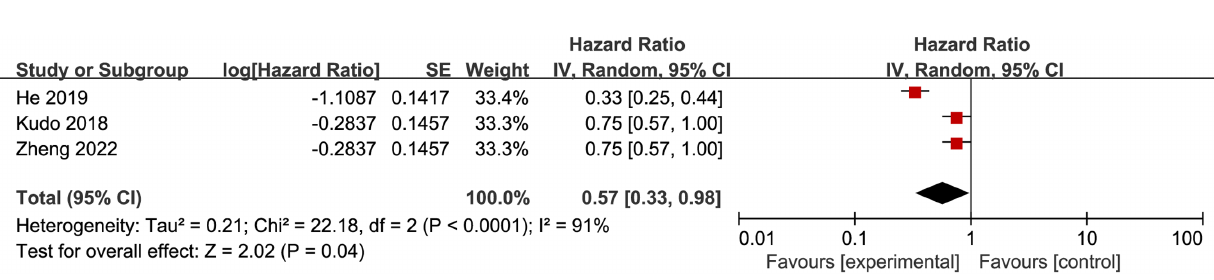
Figure 4. Forest plot comparing hazard ratio for progression-free survival between the SoraHAIC and sorafenib groups. SoraHAIC, sorafenib plus hepatic arterial infusion chemotherapy.